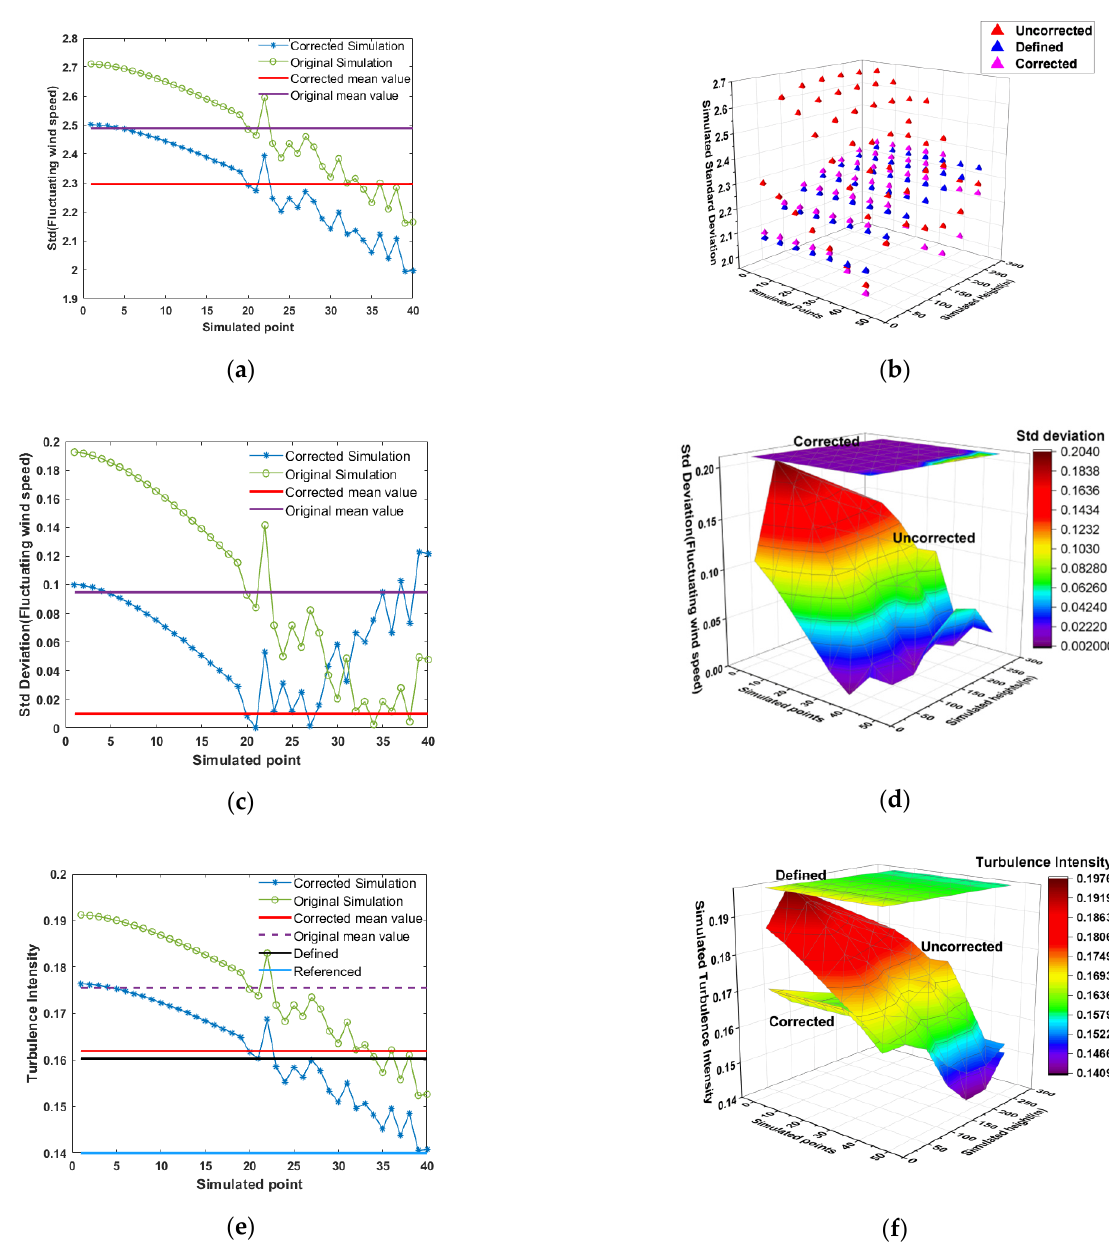
Figure 8. The contrast of standard deviation of simulated points between being corrected and uncorrected: ( a ) One-dimensional space; ( b ) Two-dimensional space; The contrast of standard de- viation deviation of simulated points between being corrected and uncorrected: ( c ) One-dimensional space; ( d ) Two-dimensional space; The contrast of turbulence intensity of simulated points between being corrected and uncorrected: ( e ) One-dimensional space; ( f ) Two-dimensional